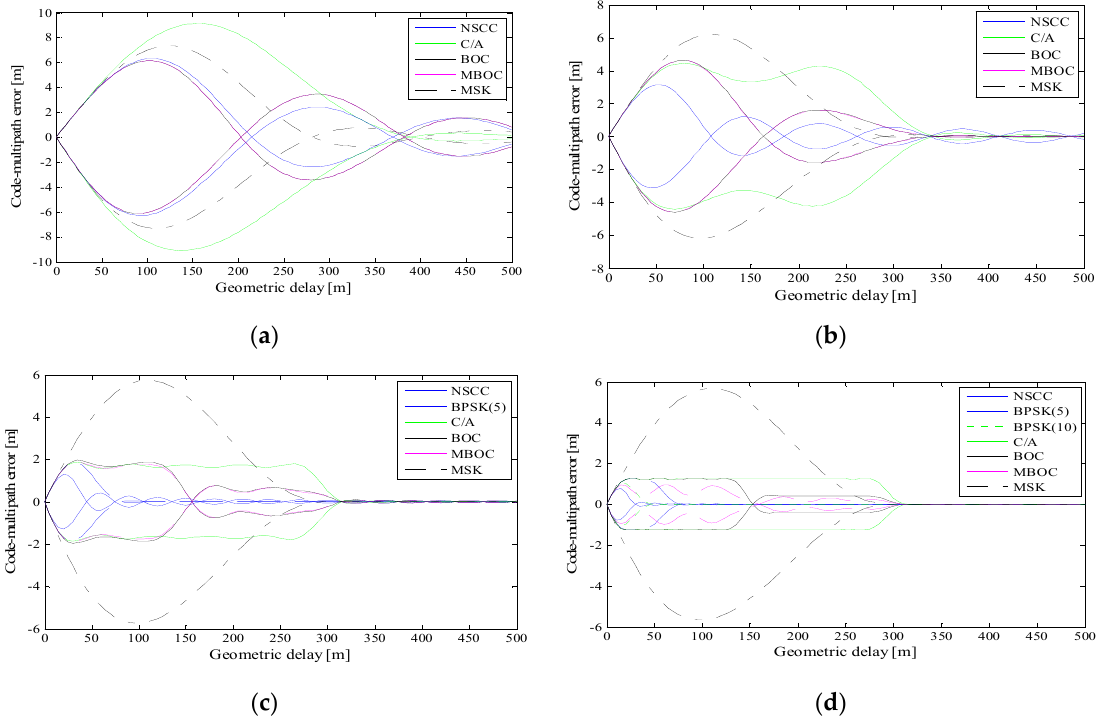
Figure 10. Multipath error envelops of pre-filtering bandwidth of 2 MHz ( a ), 4 MHz ( b ), 10 MHz ( c ), 20 MHz ( d ), a = 0.1, d = 0.1 chip.